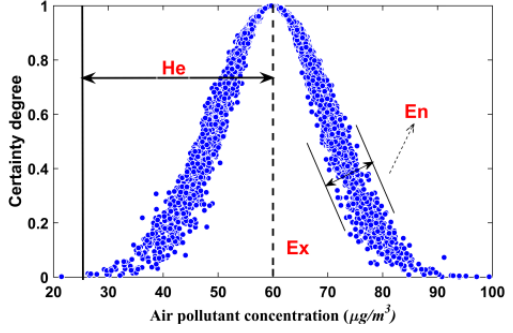
Figure 2. Normal cloud.